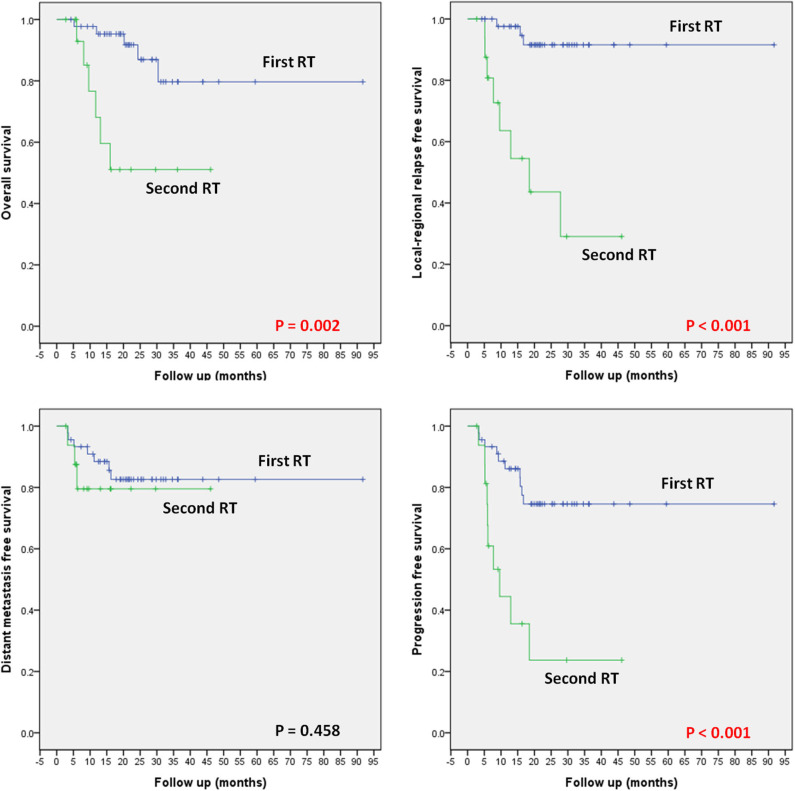
OS, LRFS, DMFS, and PFS according to the status of prior RT (i.e., first-time RT vs. re-irradiation).